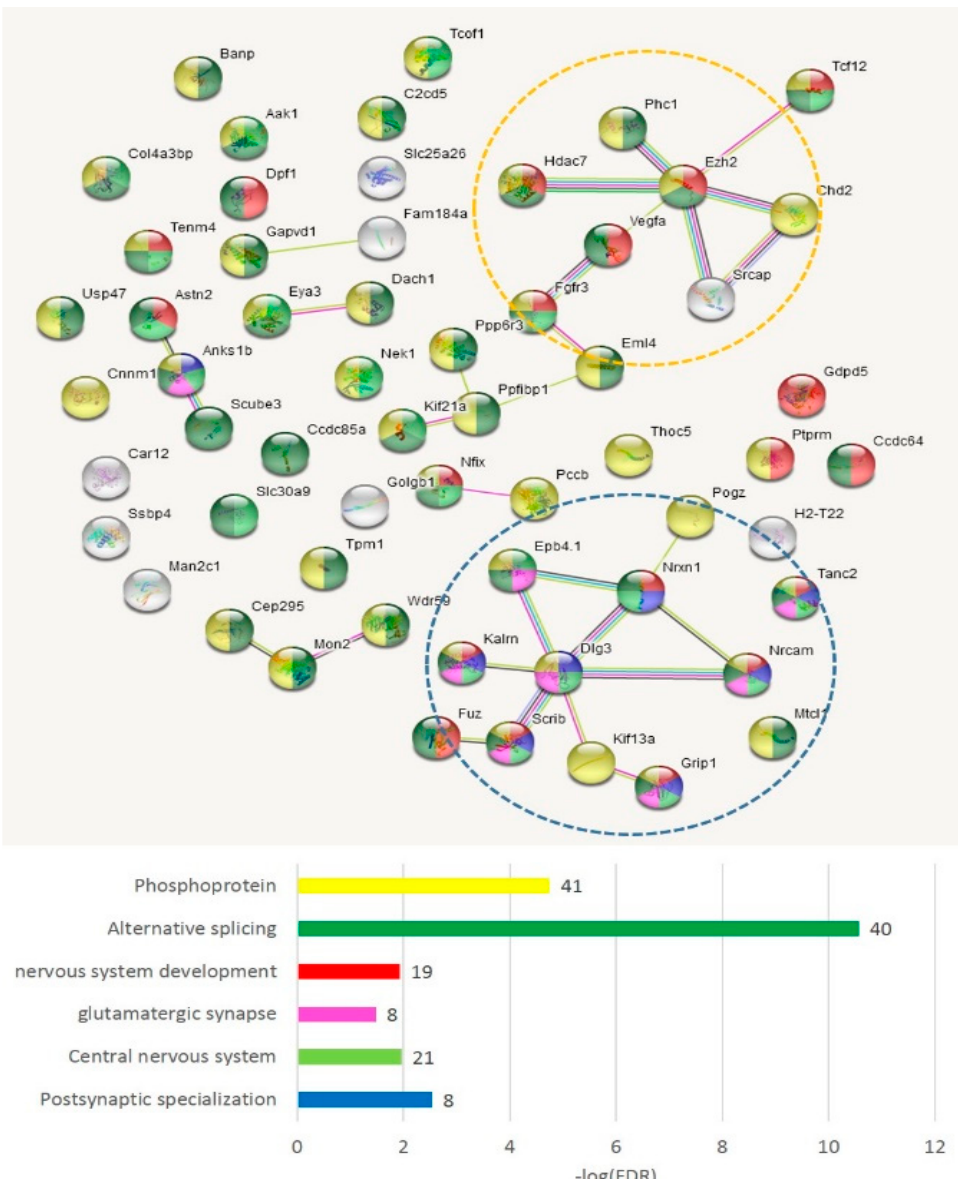
Figure 11. In total, 59 AS2 DAS genes (with both isoforms coding) underlie the synaptic dynamics in the DS neurons. The full GO clustering of 59 AS2 DAS genes is shown in Table S5b along with scalable Figure 11 plot (Table S5c). The cluster of glutamatergic synapse genes (blue dotted line and pink shaded genes) and the cluster of chromatin remodeling genes (yellow dotted line) are encircled. The GO enrichment statistics and color-coding scheme are shown in the bar plot (number of genes attached as bar labels).